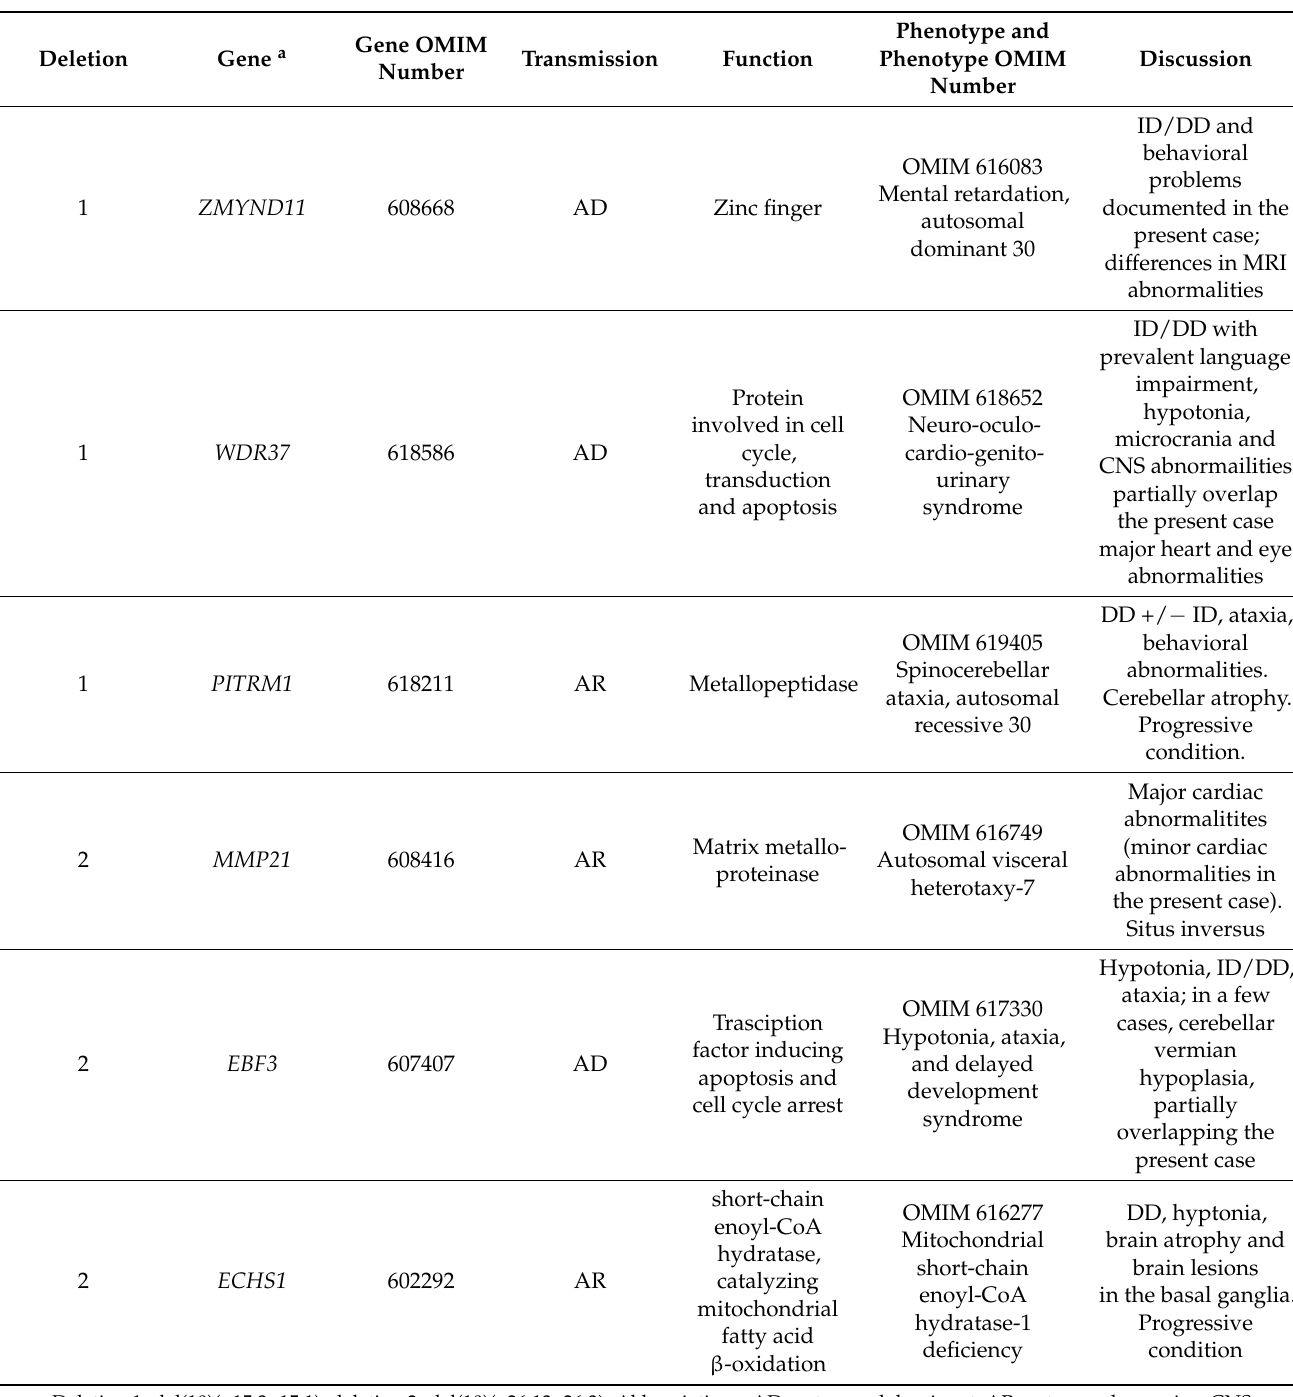
Table 1. Genes interested by deletions identified in the present